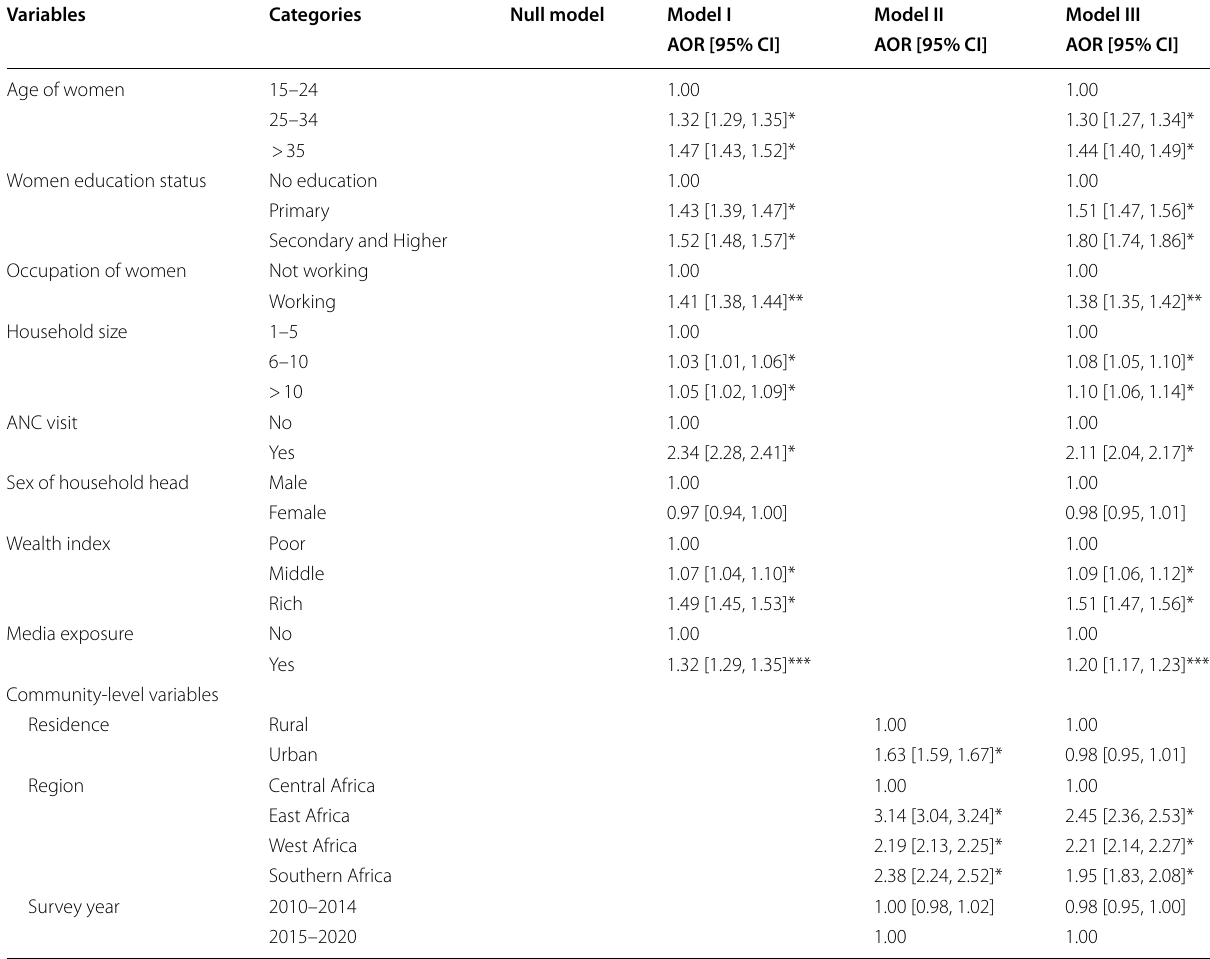
Table 4 Multilevel multivariable analysis of factors associated with knowledge of ORS packet or pre-packaged liquids for the management of diarrhea among women of reproductive age in sub-Saharan Africa, DHS